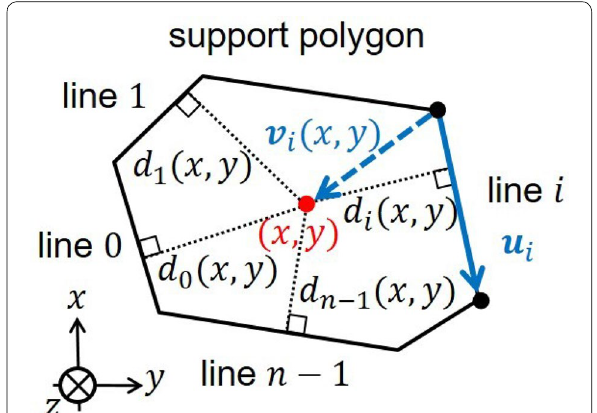
Fig. 3 n -sided support polygon and center of gravity projection ( x , y